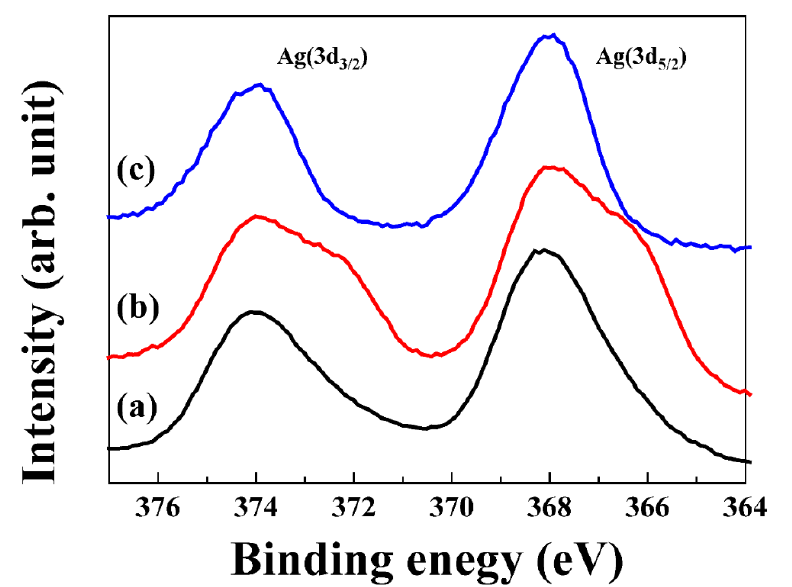
Figure 4. X-ray photoelectron spectroscopy (XPS) profiles for Ag 3d electrons of ( a ) SONP@LDH-1, ( b ) SONP@LDH-1/3 and ( c ) SONP@LDH-1/10.